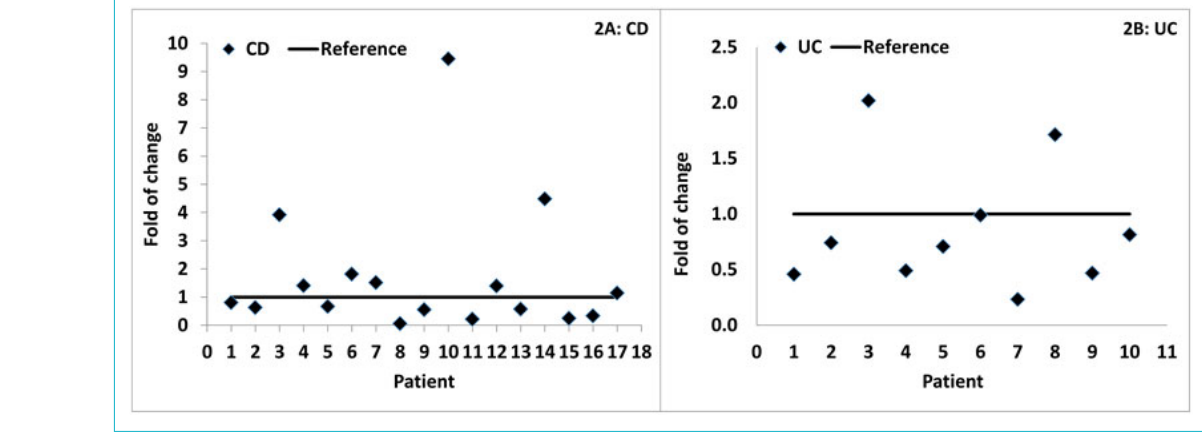
Figure 2: Comparison of haem oxidase-1 (HO-1) expression of diseased tissues with normal tissues in adult inflammatory bowel disease pa- tients. Study samples were surgical tissues from 17 Crohn’s disease (CD) patients (small intestine n = 12; large intestine n = 5) (fig 2A) and 10 ulcerative colitis (UC) patients (fig. 2B). Gene expression fold-change (normalised to glyceraldehyde 3-phosphate dehydrogenase) in diseased tissue/adjacent normal tissue All experiments were repeated three